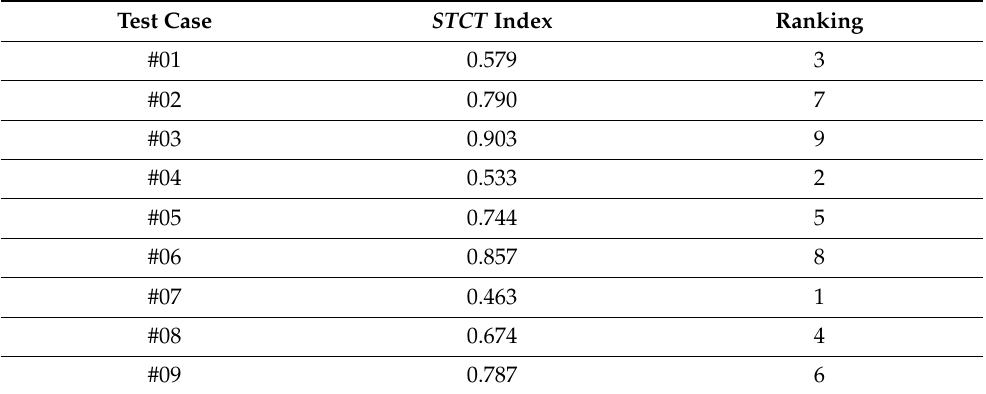
Table 10. Suspension and tire cornering performance index